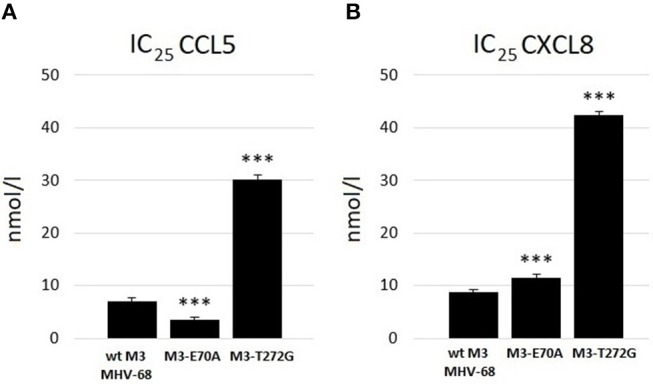
Comparison of the strength of binding of wtM3 and mutant M3-E70A and M3-T272G proteins to (A) CCL5 and (B) CXCL8. IC25 expresses the protein concentration needed to bind 25% of the chemokines used in the assay. The *** above the results of each mutant indicates that the difference from wtM3 is statistically significant at the p < 0.001 level. The results shown are an average of three independent experiments.